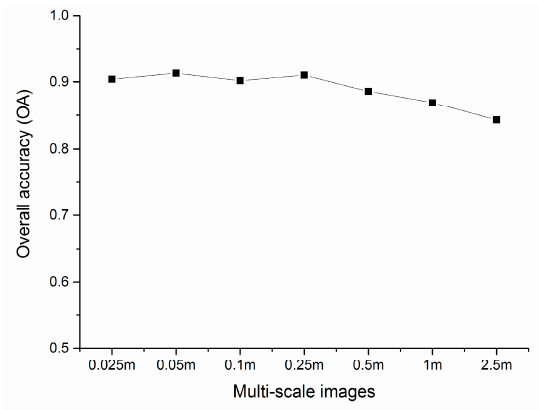
Figure 9. Variation of overall accuracy (OA) under the condition of appropriate feature number and segmentation scale with different spatial scale.